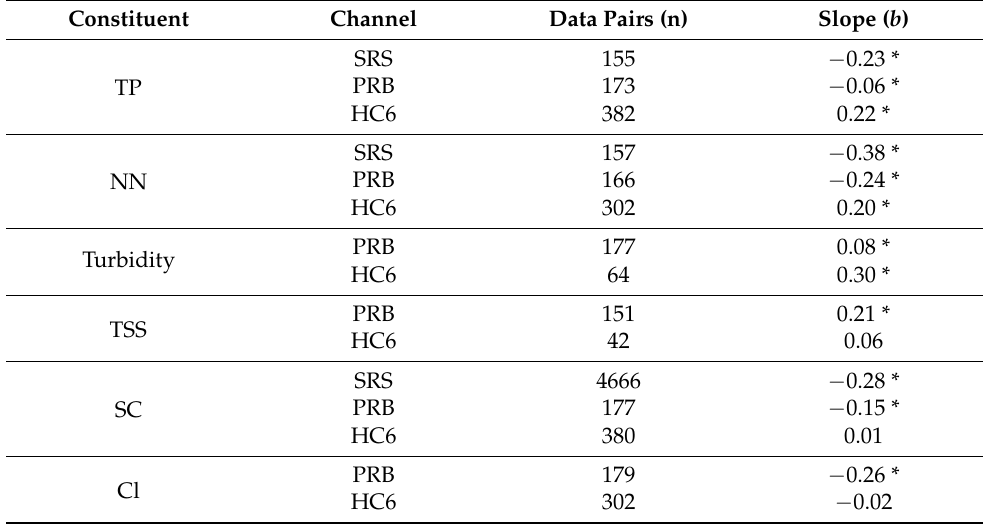
Table 3. Log ( C )-log ( Q ) regression slopes ( b ) for water quality constituents at SRS, PRB, and HC6 for the period 2004 to 2018.